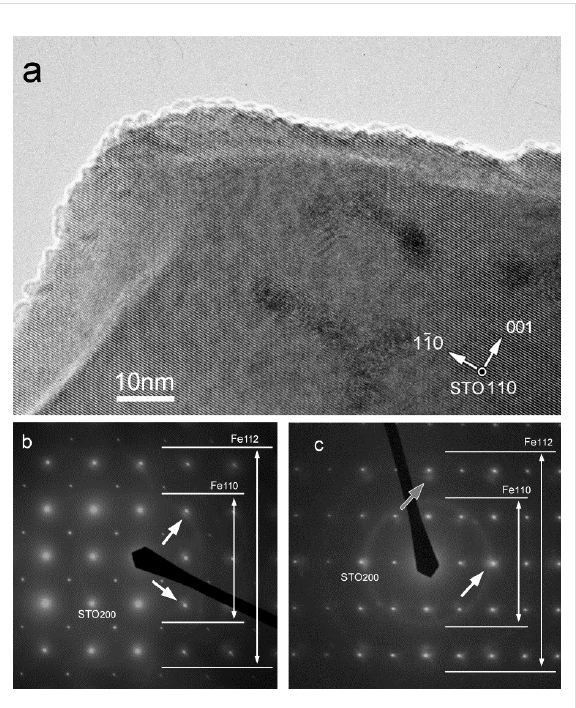
Figure 1: A TEM image and diffraction patterns of Fe nanoparticles on STO substrates. a) TEM plan-view image of Fe nanoparticles on STO(110); b,c) diffraction patterns taken from STO(001) and STO(110) substrates, respectively.